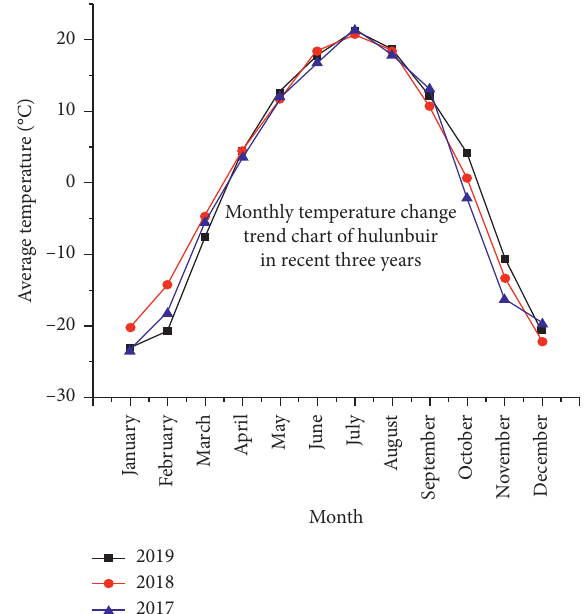
Figure 2: The temperature trend chart of the study site for the most recent three